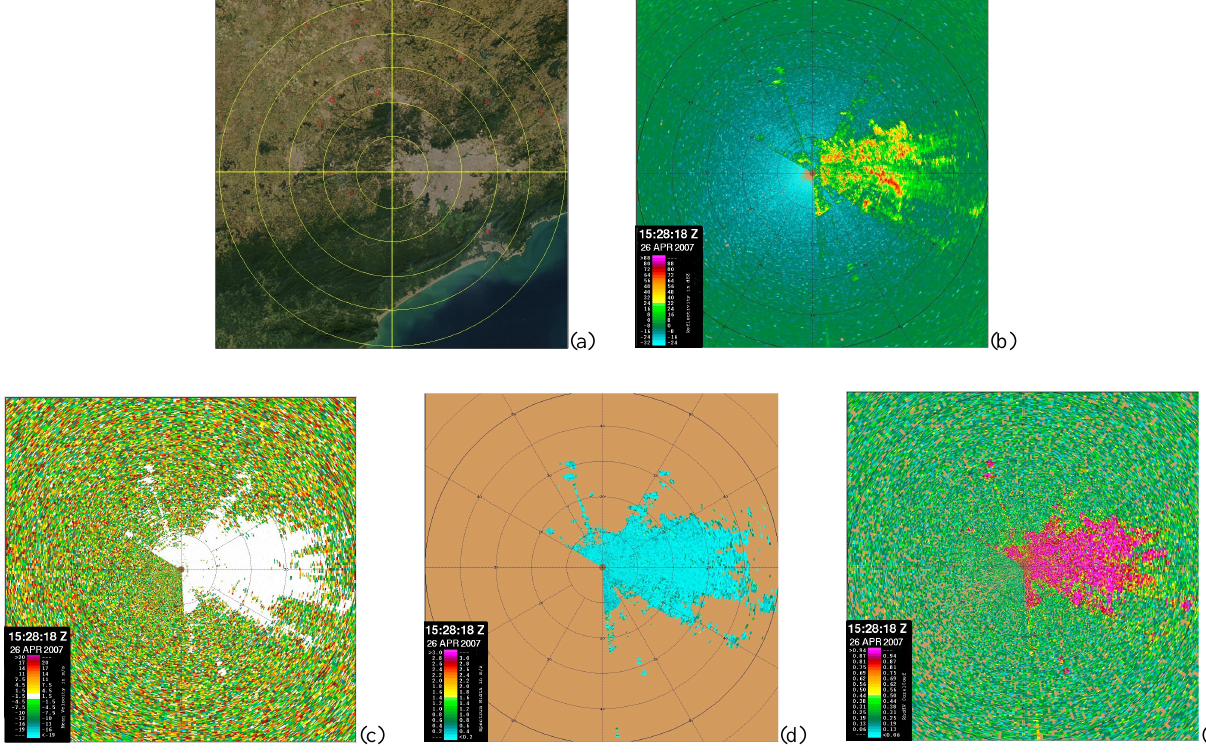
Fig. 3. (a) ACQUA/MODIS image of eastern S˜ao Paulo state on 20 July 2003. The cross indicates the MXPOL site (23 ◦ 32.2 0 S; 46 ◦ 52.8 0 W) in Barueri City, S˜ao Paulo, Brazil, on 26 April 2007. The large brown area east of the MXPOL site is the MASP. Concentric circumferences spaced every 20km. Image source: http://visibleearth.nasa.gov/. PPI at 0.6 ◦ elevation of reflectivity – Z h (b) dBZ, radial velocity – V r (c) ms − 1 , spectral width – SW (d) ms − 1 , and correlation coefficient VH – ρ oHV (e) obtained with MXPOL at 15:28UTC on 26 April 2007. Ranges, directions and colour scales are indicated in each